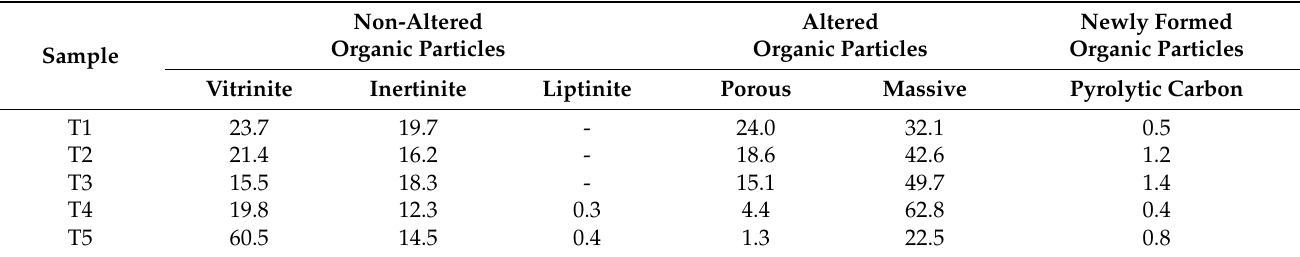
Figure 6. Quantification of organic particles in the thermally altered Tashan coal. Table 2. Quantification of organic particles in thermally altered coal (vol.